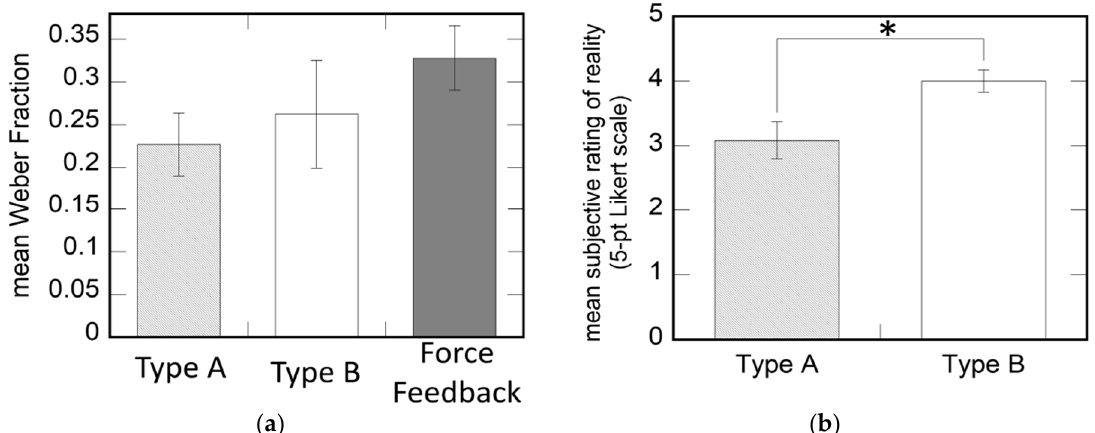
Figure 12. Average Weber fraction according to the haptic feedback type ( a ). The results concerning the haptic condition come from earlier research [89]. Mean subjective assessment of realism ac- cording to the haptic interface type ( b ) [83]. For both images, the standard errors are shown by the error bars. The single-star symbol (*) indicates that the observed significance level (p-value) of the test is lower than 0.05; in detail, it was equal to 0.013 for the test reported in ( b ).